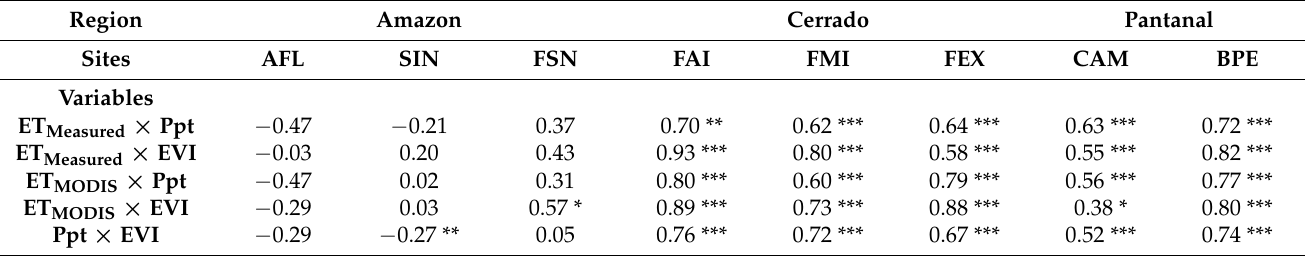
Table 4. Pearson’s correlation coefficient r between cumulative measured (ET Measured ) and